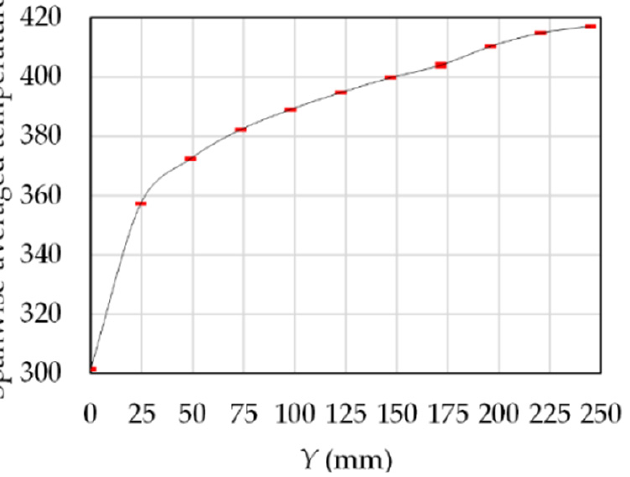
Figure 11. The spanwise-averaged temperature and grid convergence index on the surface of the conventional serpentine channel at Re = 10,000.